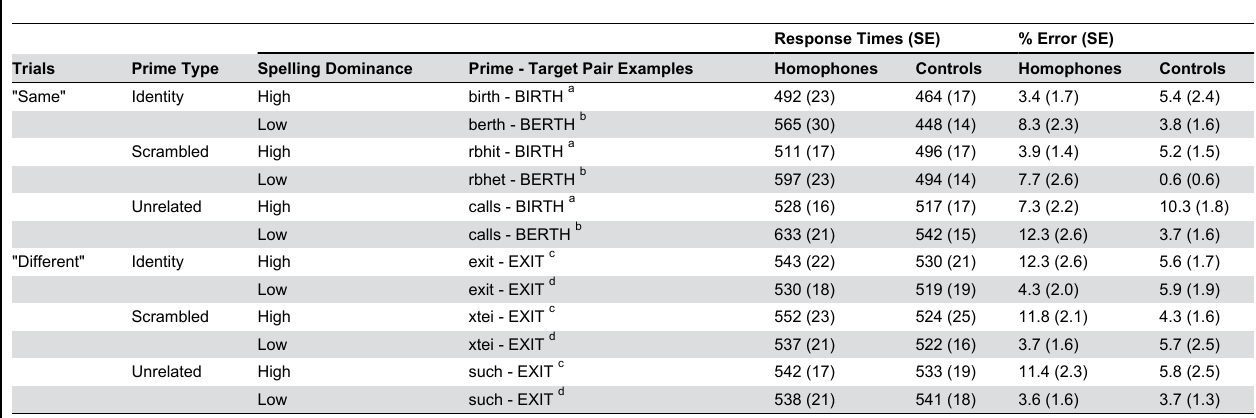
Table 4. Mean response times in milliseconds, percentage errors, and standard error (SE) of the means of Experiment